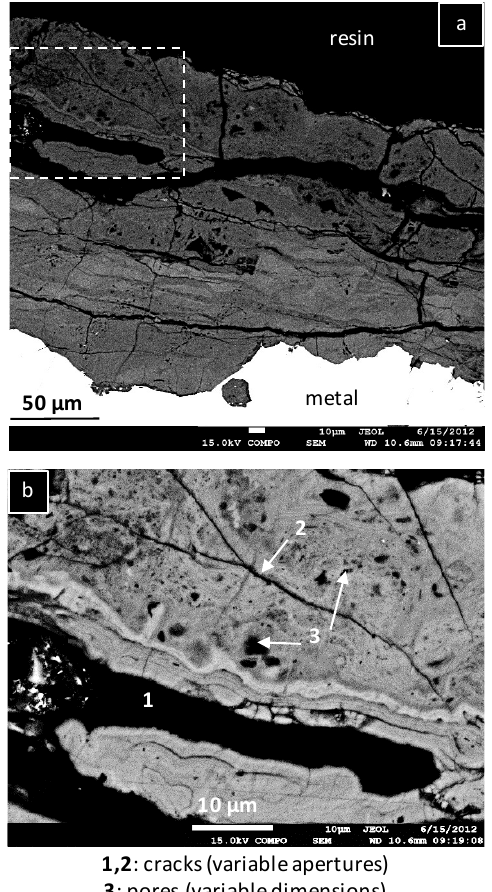
Figure 3. FESEM images of the corrosion product layer in the backscattered electron mode. Image ( b ) corresponds to a magnification in the white dot rectangle drawn on the image ( a ). 1&2: cracks with various apertures; 3: pores with various sizes.